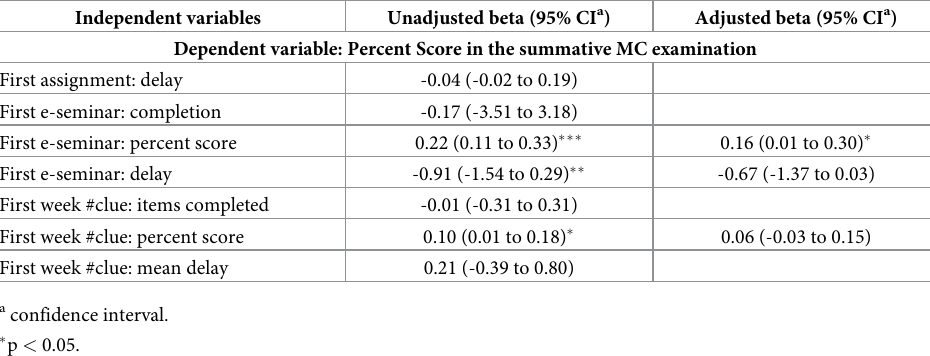
Table 2. Early predictors of student